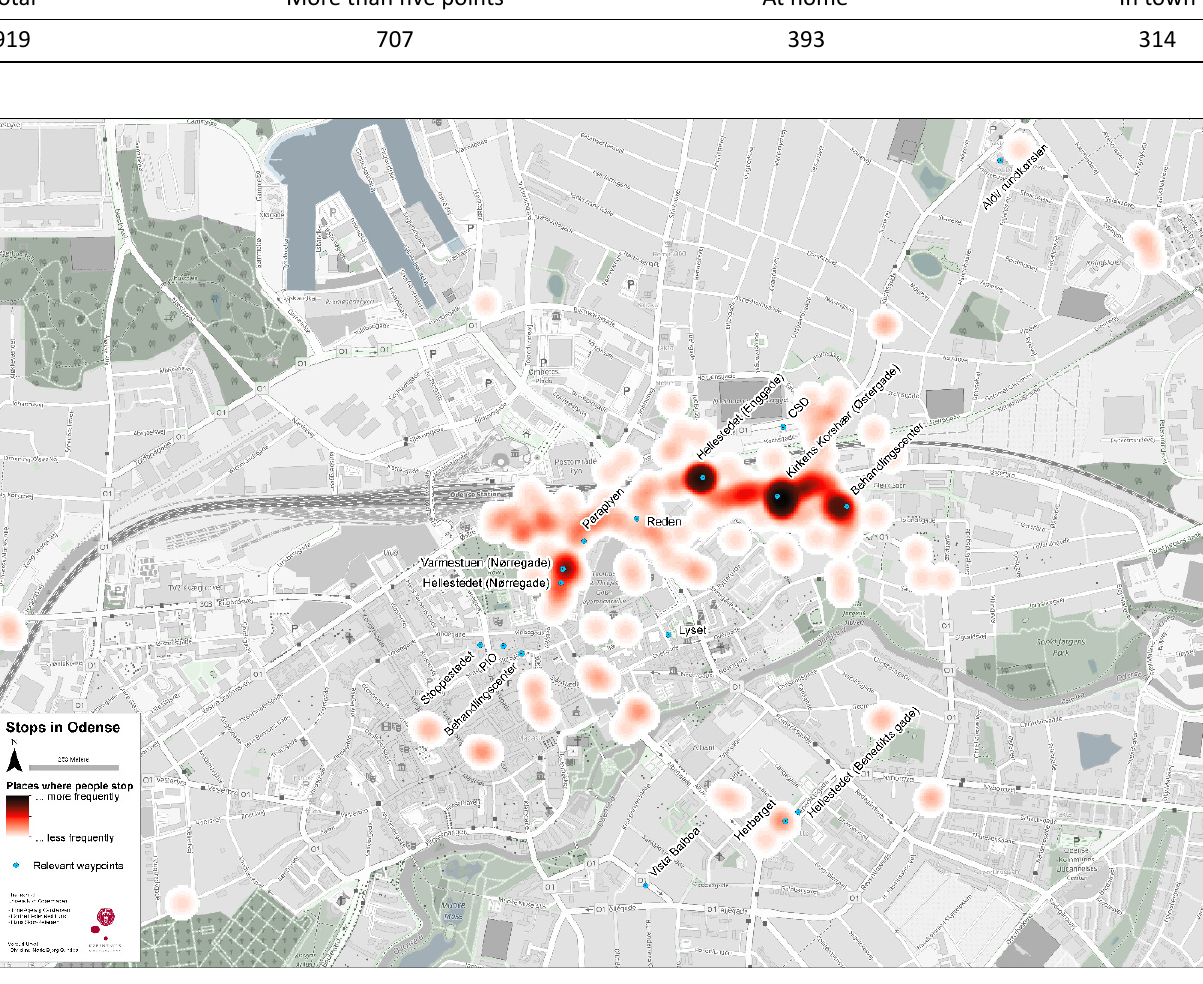
Figure 1. Stops “in town” (not “at home”) in downtown